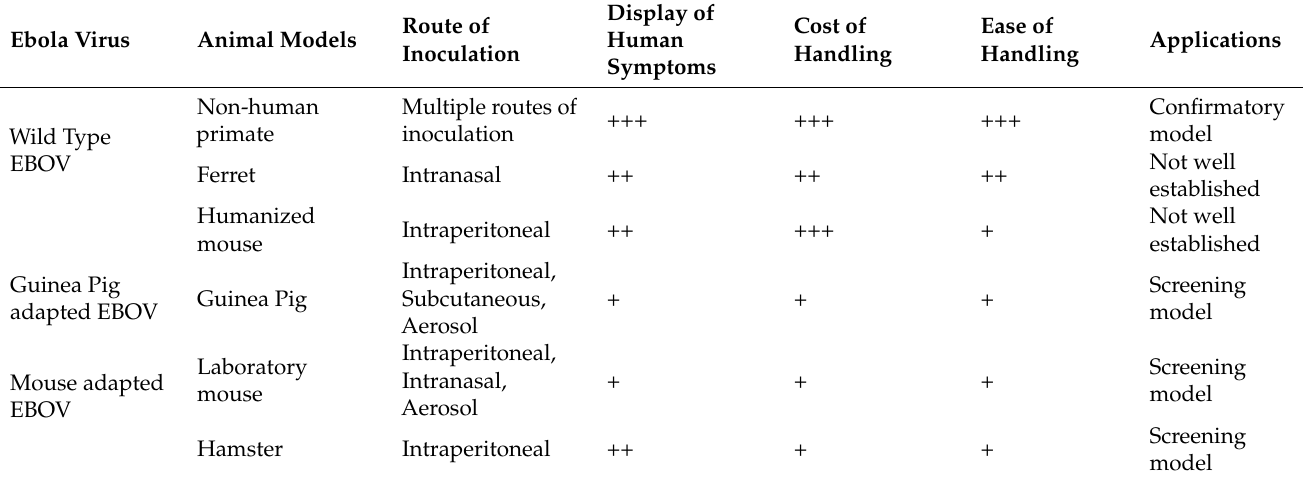
Table 3. Animal models for development of EBOV Vaccines [+++: High; ++: Moderate; +: Low].